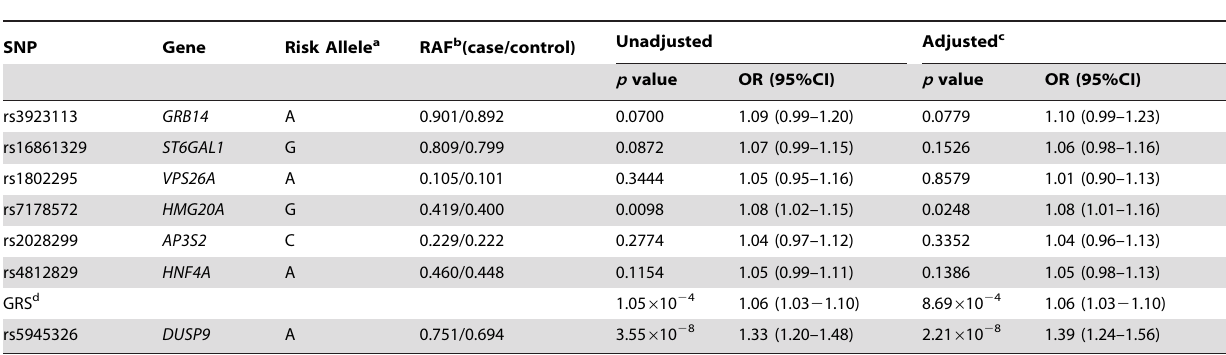
Table 3. Association of 7 SNPs with type 2 diabetes in the Japanese